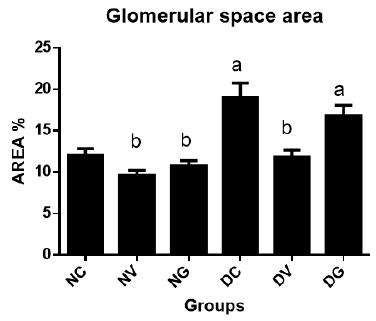
Figure 6. Area occupied by the glomerular space per glomerulus. Data represented as means ± SEM. a p < 0.05 vs. normal control. b p < 0.05 vs. diabetic control. NC: normal control; NV: normal control